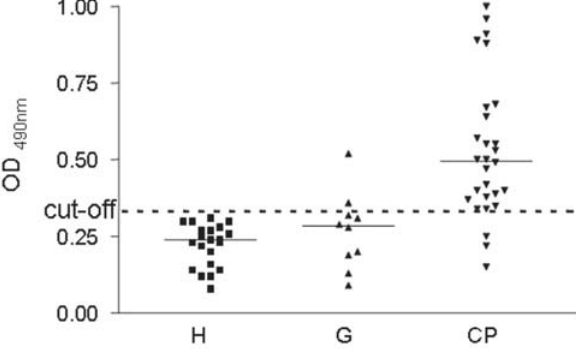
values after ELISA 490